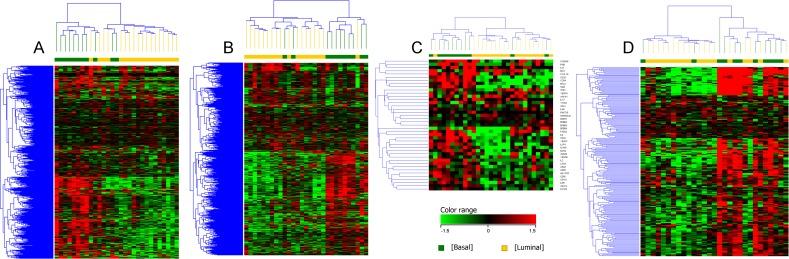
Expression patterns of immune signatures in canine basal and luminal iUC.A list of immune signature genes from different immune cell types, checkpoint inhibitors, antigens and genes covering both adaptive and innate immune response (nCounter, Nanostring, PanCancer Immune Profiling Panel, Seattle, WA) (A), interferon-γ inducible genes (from the Interferome database [22] (B), immunosuppressive genes regulating the function of myeloid derived suppressor cells (MDSCs) and regulatory T-cells (C), and genes enriched in immune system process identified from GO:0002376 (D) were used to visualize the gene expression patterns that exist in canine iUC. Normalized intensity values were used for supervised hierarchical clustering using Euclidean distance metrics and Ward’s linkage algorithm as a distance metric. Note the higher expression of immune genes in the canine basal iUC samples (A,B,C,D). Two basal tumors were found to be immune “cold”, and a minority of luminal tumors were identified as immune “hot”.